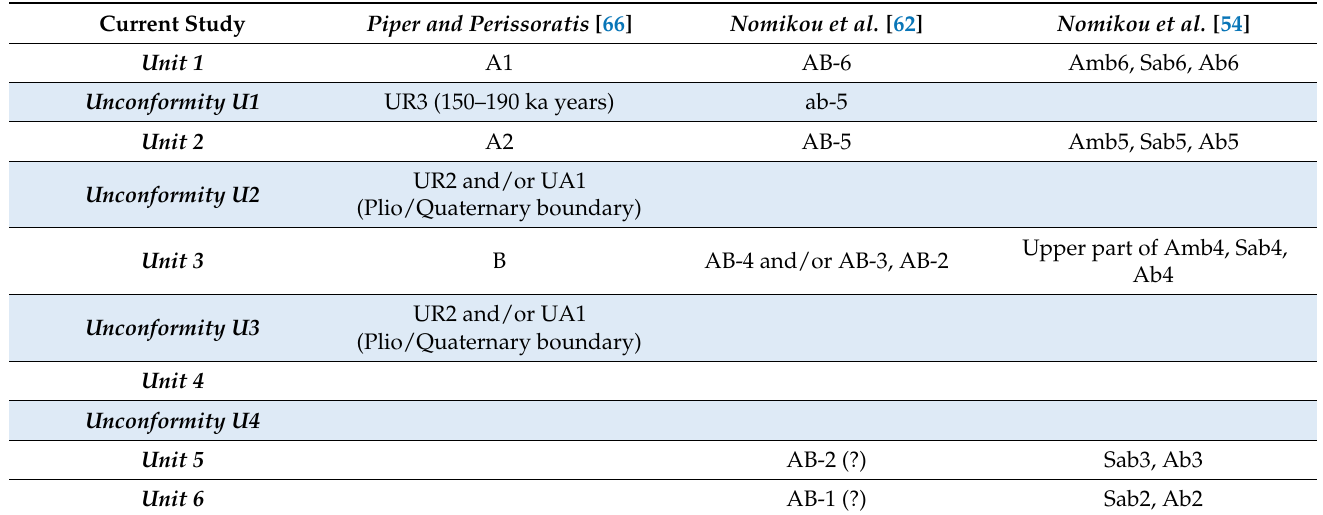
Table 2. Seismic stratigraphic features in the current study and in the